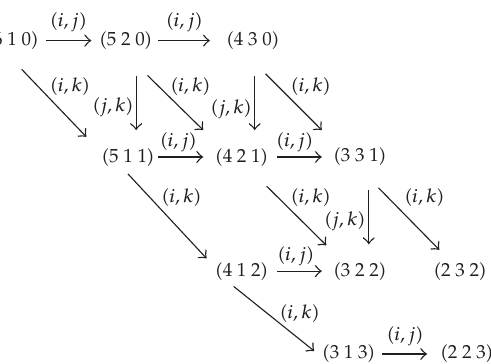
Figure 7: The initial Young diagram (cid:3) 610 (cid:4) with its set of attainable diagrams. The arrows characterize the individual mixing transitions with the corresponding indices of the diagram vector, i (cid:7) 1, j (cid:7) 2, and k (cid:7) 3.